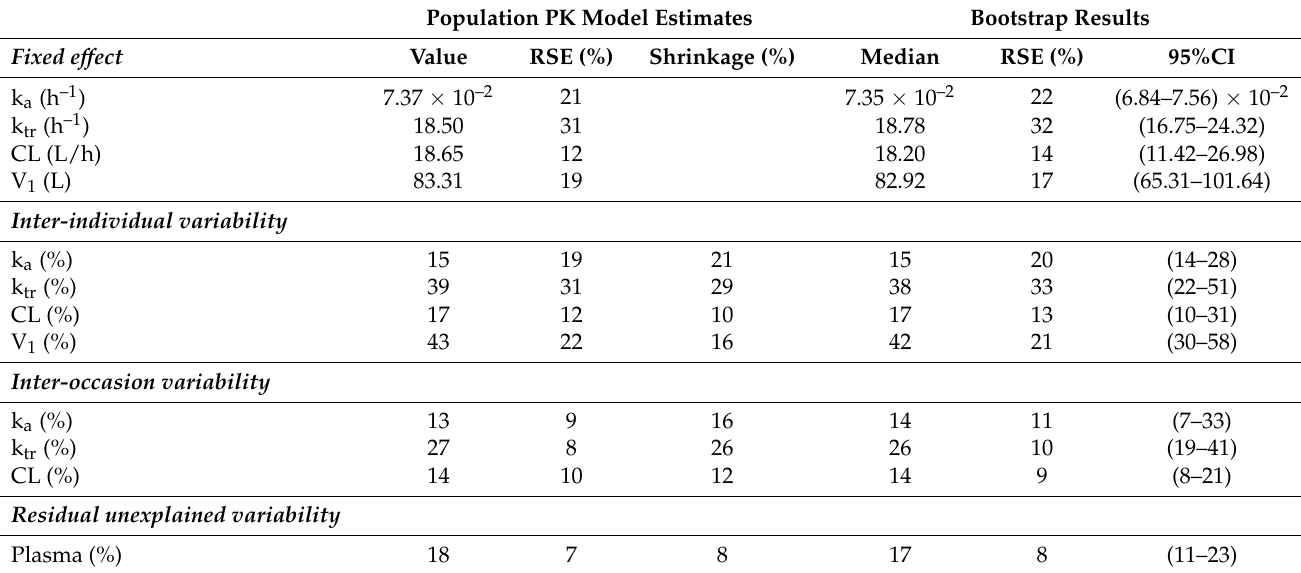
Table 3. Final population pharmacokinetic parameters of 100 mg of desvenlafaxine in healthy volunteers after single-dose